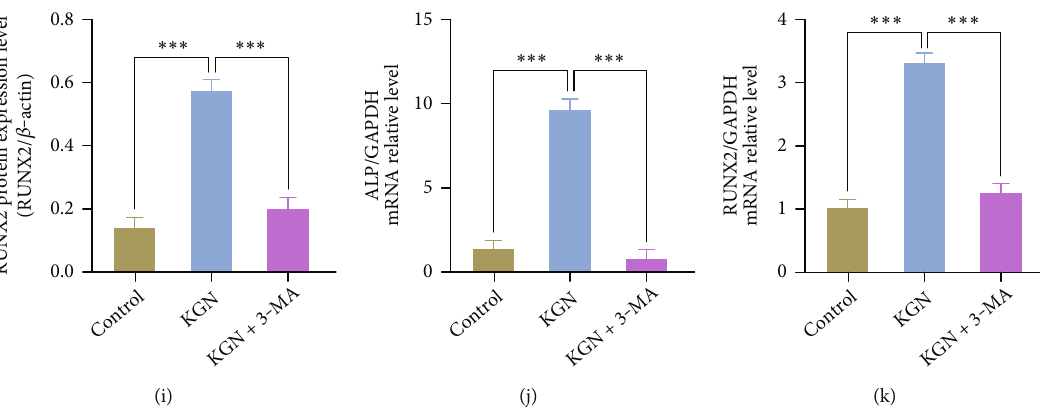
Figure 3: KGN increases the osteogenic capability of BMMSCs via upregulating autophagy. ARS (a) and semiquanti fi cation (b) of mineralized nodules. 3-MA-mediated autophagy suppression inhibited KGN-induced BMMSC osteogenesis. Scale bar = 500 μ m. ∗ p < 0 : 05 and ∗∗∗ p < 0 : 001 , one-way ANOVA test. (c, d) Detection of ALP (green), Runx2 (green), and DAPI (blue) by immuno fl uorescent staining in BMMSCs. (e, f) Semiquanti fi cation of (c) and (d). 3-MA-mediated autophagy suppression inhibited KGN-induced expression of osteogenic genes. Scale bar = 50 μ m. ∗∗ p < 0 : 01 and ∗∗∗ p < 0 : 001 , one-way ANOVA test. (g) Western blotting, (h, i) semiquanti fi cation of (g), and qRT-PCR assay (j, k) of ALP and Runx2. 3-MA-mediated autophagy suppression inhibited KGN-induced expression of osteogenic genes. ∗∗ p < 0 : 01 and ∗∗∗ p < 0 : 001 , one-way ANOVA